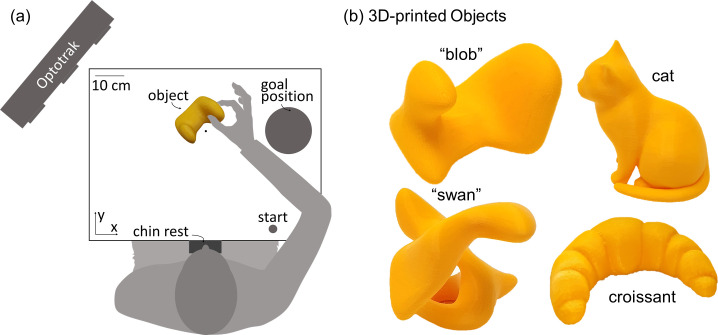
Setup and stimuli for Experiment 3.(a) Experimental setup. Seated participants performed grasping movements with their right hand. Following an auditory signal, they opened their eyes, and moved from the starting position to the object and grasped it with a precision grip. They transported and released the object at the goal position and returned to the start position. (b) We employed four 3D-printed objects. Two objects had an abstract shape (that here we name ‘swan’ and ‘blob’), the other two objects were printed versions of a croissant and a cat. They were presented to the participant in the orientations displayed in here.